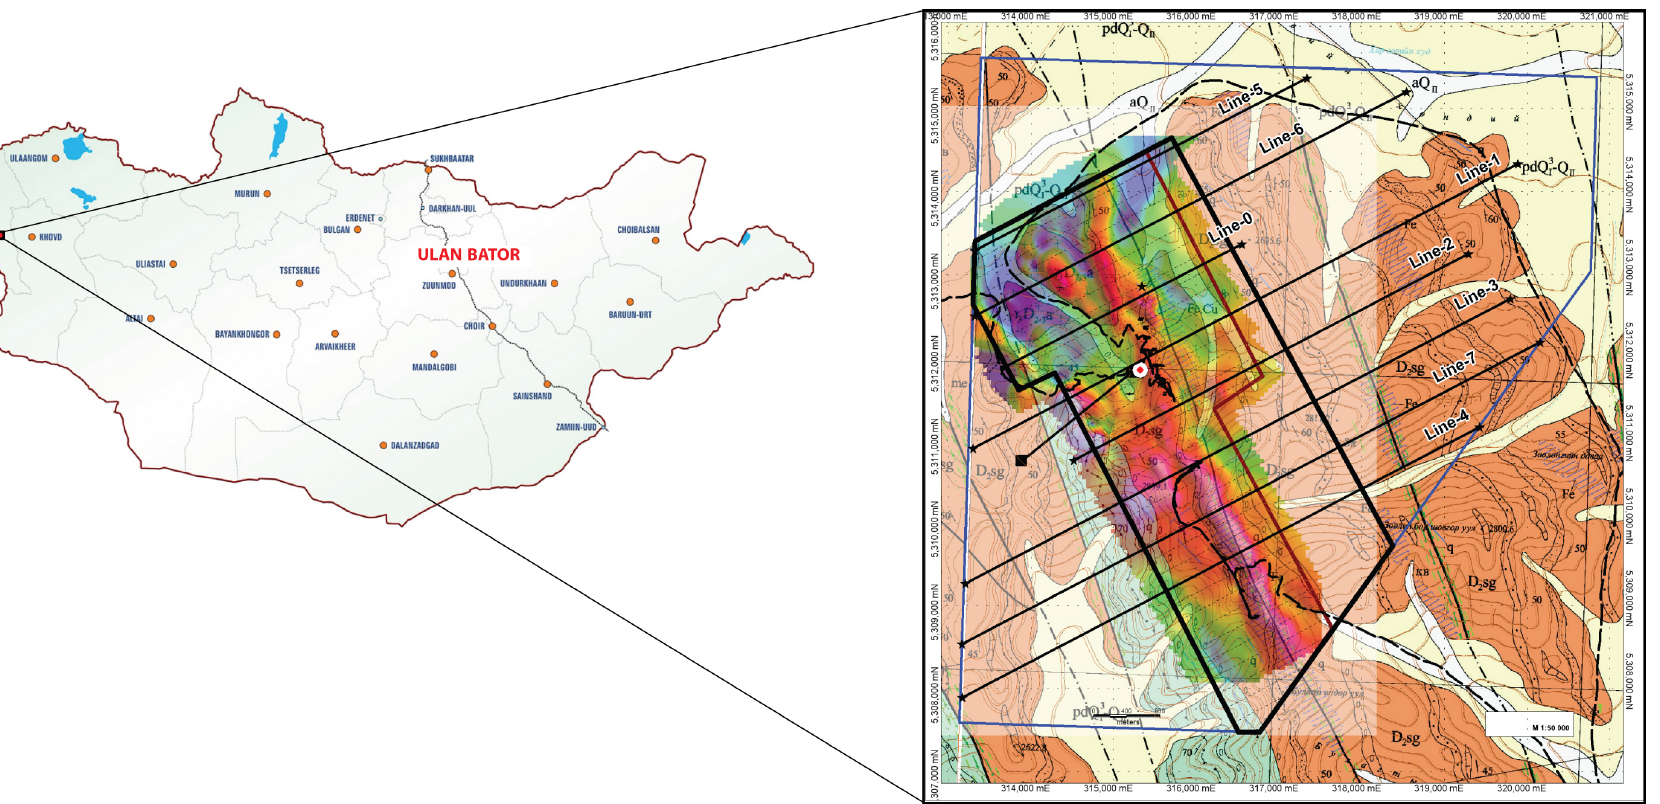
Figure 4. Location map of the geophysical survey area in